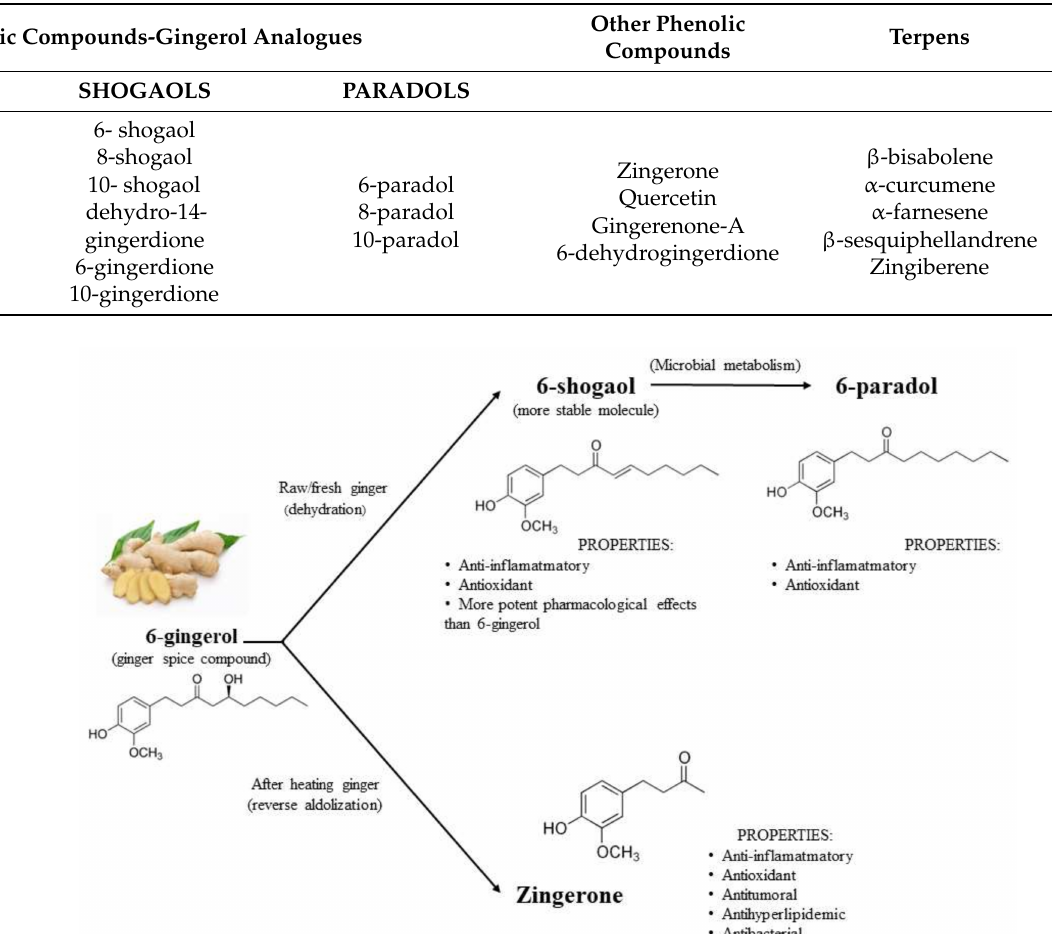
Table 1. Principal bioactives of the compounds of ginger.